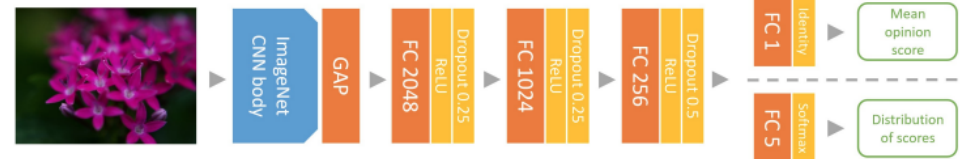
Figure 1. End-to-end architecture of trained KonCept512 model to predict MOS values